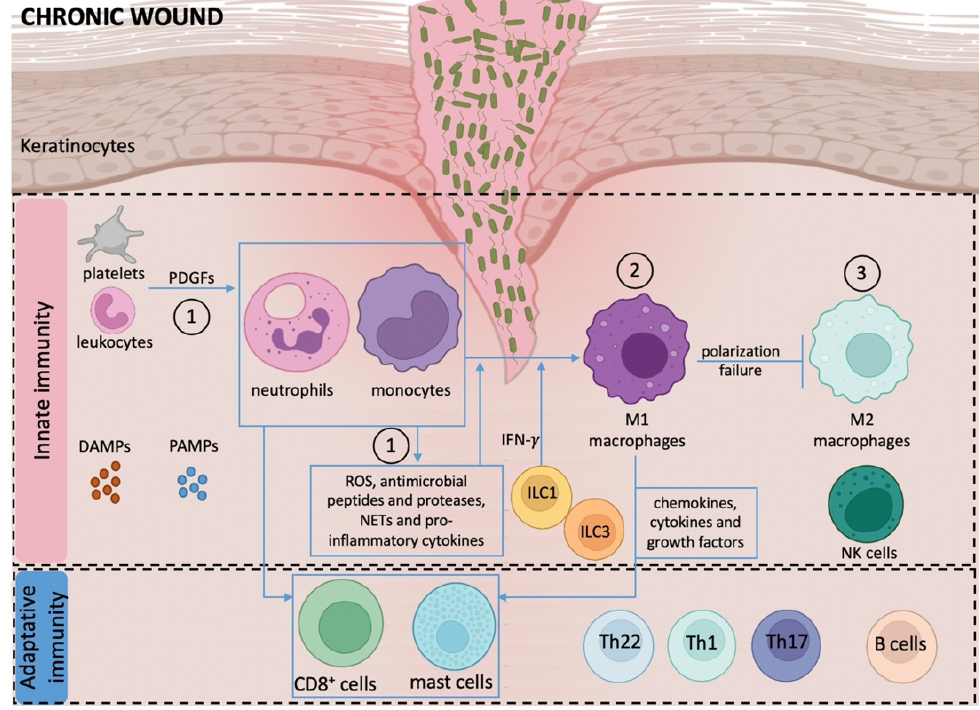
Figure 3. Schematic representation of the main players of innate and adaptative immunity in response to chronic wounds. Upon tissue injury, tissue-resident immune cells, including macrophages, sense tissue damage and trigger the mobilization of other immune cells. Damage-associated molecular patterns (PAMPs) and pathogen-associated molecular patterns (DAMPs) activate resident immune cells, such as mast cells, Langerhans cells, T cells, and macrophages, by binding pattern recognition receptors to elicit downstream inflammatory pathways. Platelet-derived growth factors (PDGFs), released by platelets and leukocytes, play an important role in initiating the chemotaxis of neutrophils and monocytes. Monocytes migrate into the wound and mature into macrophages. Neutrophils and activated macrophages secrete reactive oxygen species (ROS), antimicrobial peptides, proteases, and pro-inflammatory cytokines to amplify the inflammation and to help eliminate pathogens. However, the prolonged presence of pro-inflammatory macrophages (M1) in the wound environment and the overexpression of inflammatory mediators lead to the failure of the reparative (M2) phenotype polarization. In addition, adaptive immune cells, such as cytotoxic T cells (CD8 + cells), mast cells, T helper (Th) cells, and B cells, were shown to participate in the process. Arrows indicate pathway induction and numbers indicate the corresponding healing phases ((1) homeostasis, (2) inflammation, (3) proliferation). NETs, neutrophil extracellular traps; IFN- γ , interferon gamma; ILC, innate lymphoid cells; NK, natural killer cells.